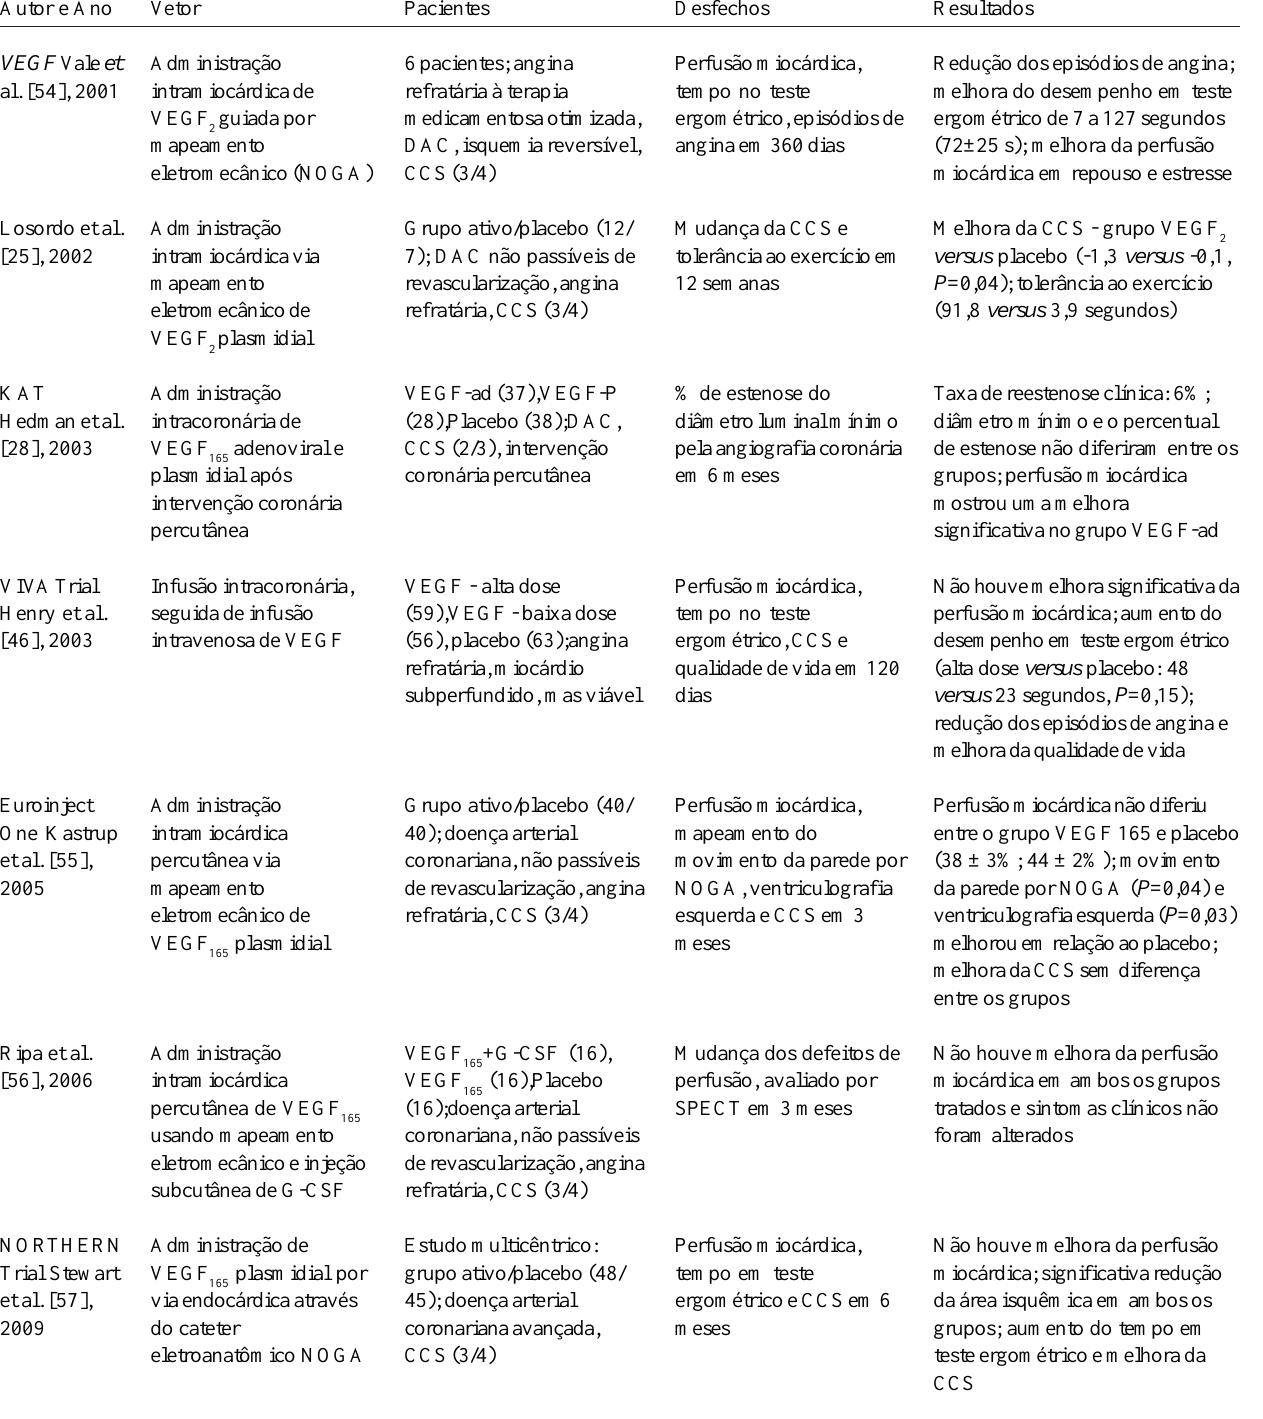
Tabela 2. Ensaios Clínicos envolvendo Terapia Gênica com VEGF via percutânea.